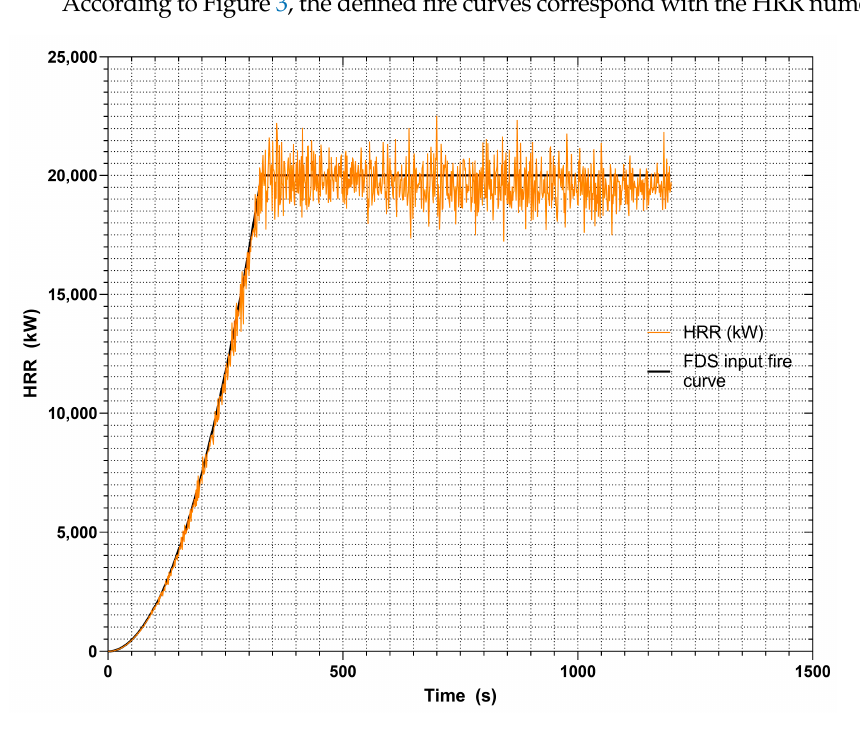
Figure 3. Input fi re ramp curve and numerical results. Figure 3. Input fire ramp curve and numerical